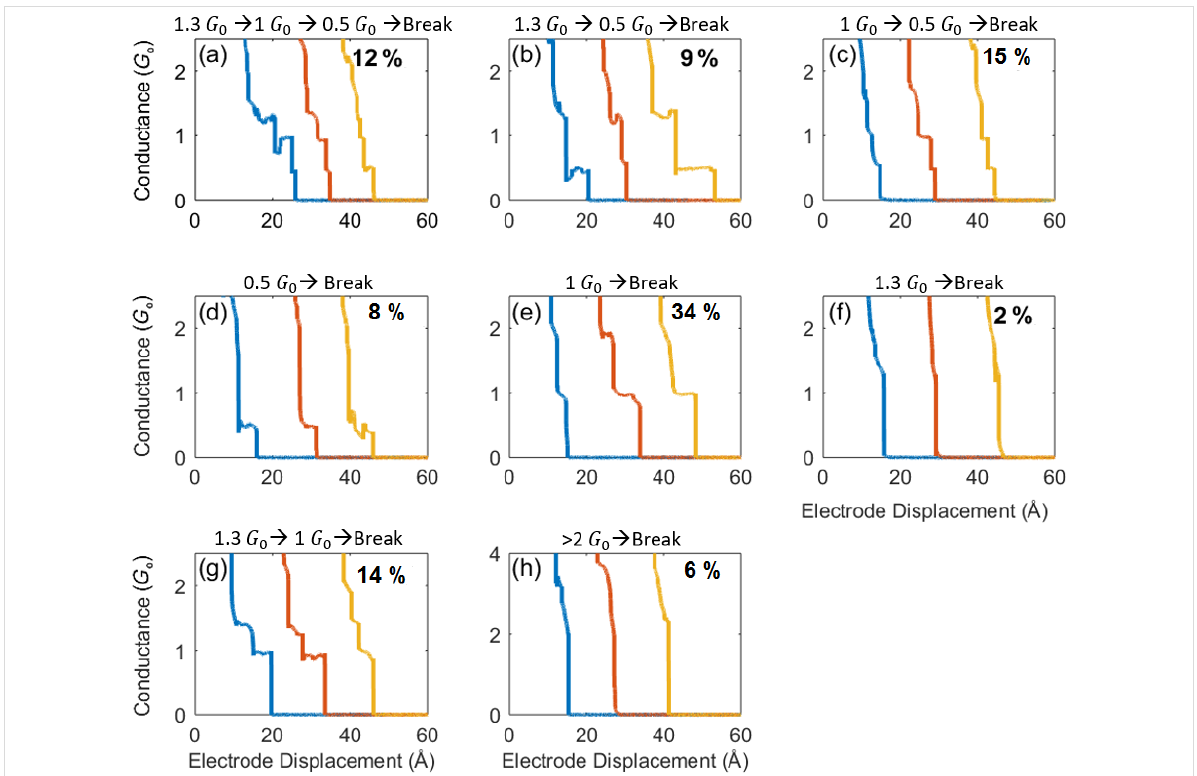
Figure 4: (a − h) Examples for sets of conductance traces taken during repeated junction breaking with different combinations of plateaus (an ensem- ble of 50,000 traces was analyzed). The different sets illustrate a variety of scenarios for the structural evolution of the Ag–vanadocene junction. The percentage of each set of traces is indicated. For the sake of simplicity we ignore molecular configurations with conductance around 10 − 2 –10 − 3 G 0